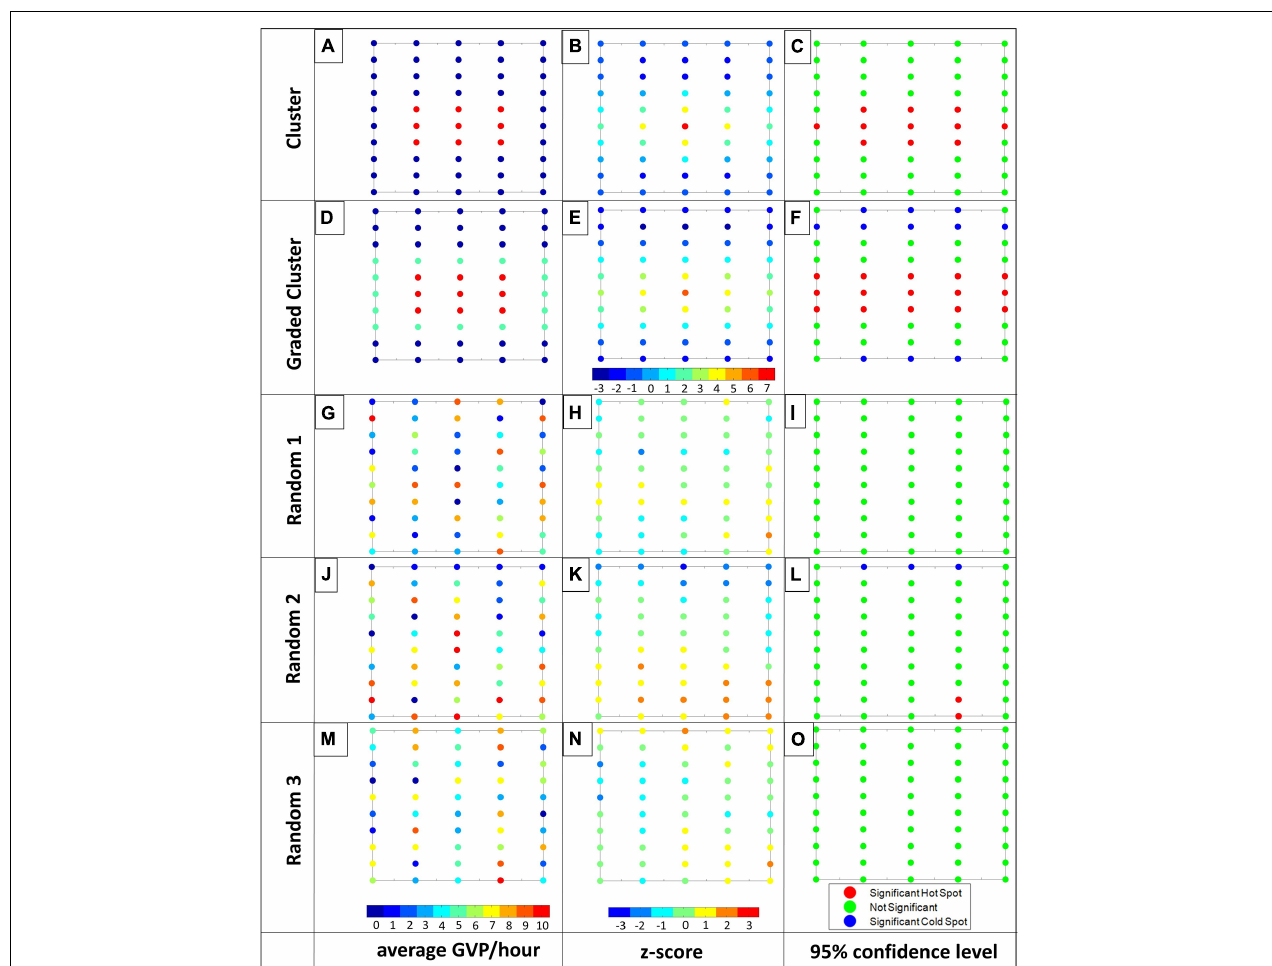
FIGURE 4 | Visualization of the Gi* results for the Cluster, Graded Cluster, Random 1, Random 2, and Random 3 patterns (top to bottom). From left to right: first column: average GVPs per hour with color bar ranging from 0 (dark blue) to 10 (red); second column: Gi* z-statistic with color bar ranging from –3 (dark blue) to 7 (red) for the Cluster and Graded Cluster patterns and from –3 (dark blue) to 3 (red) for the random arrangements; third column: 95% confidence level, where red indicates a significant hot spot and blue indicates a significant cold spot, while green is not significant. For ease in displaying, individual hydrophone values were rounded to the closest number on the color bar for columns one and two. Letters associated with each plot are used for ease in referencing individual plots in the